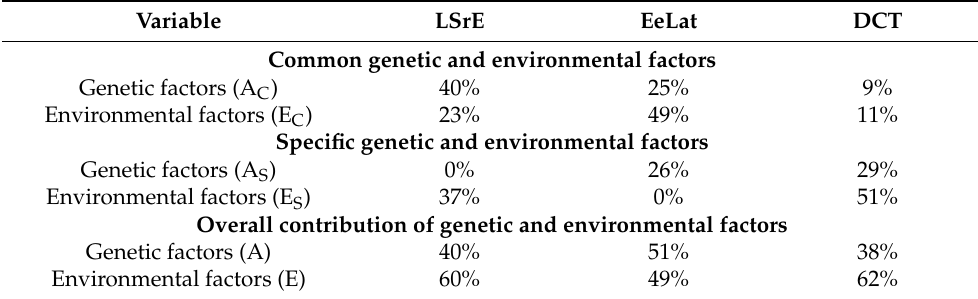
Table 2. Proportion of common and specific genetic and environmental factors contributing to heritability of diastolic measurements.